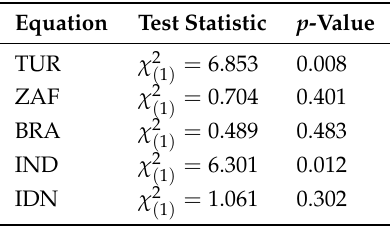
Table 3. Ljung-Box test.